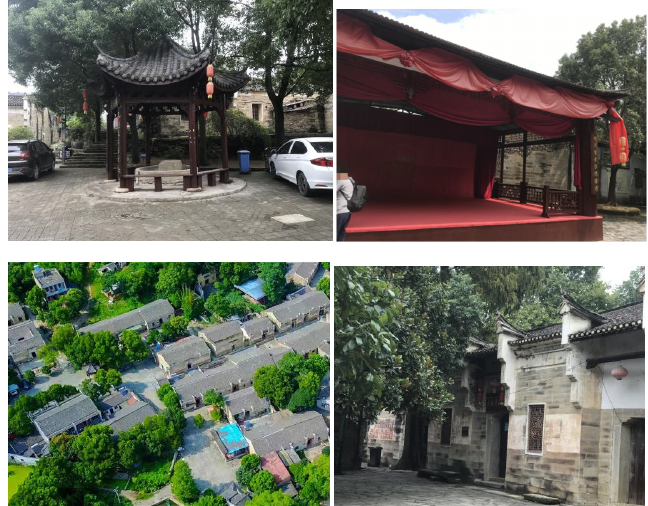
Figure 2. Field survey of Dayu Bay. Source: The author photographed and obtained the written consent of the traveler.